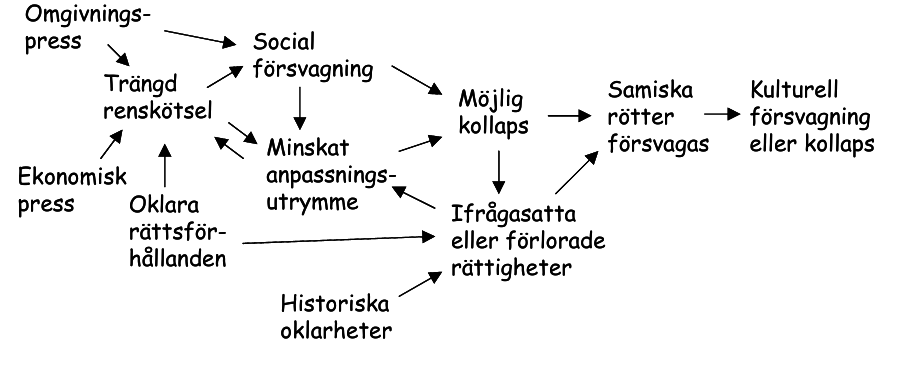
Fig. 5. Möjliga händelseförlopp till följd av försämrad resiliens i renskötseln. Den yttersta konsekvensen kan bli att den samiska kulturen utarmas och går